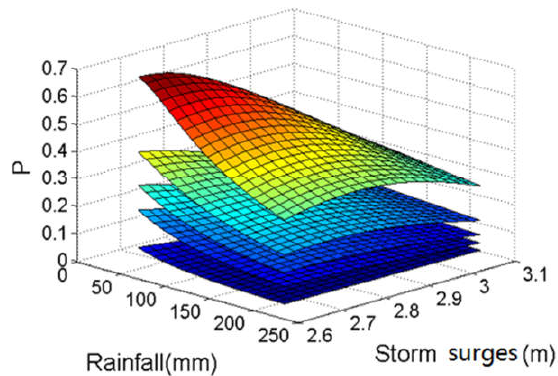
Figure 10. Co-occurrence probability of rainfall and storm surges under different return period (RP) typhoon conditions (from top to bottom: 50-year RP typhoon, 20-year RP typhoon, 10-year RP typhoon, 5-year RP typhoon, no typhoon).